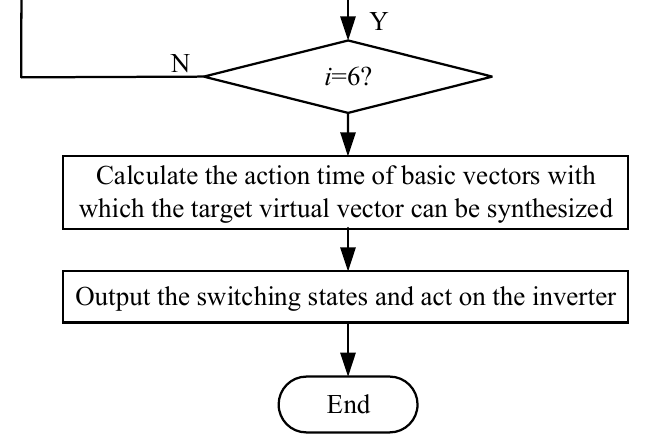
Figure 8. Implementation flowchart.